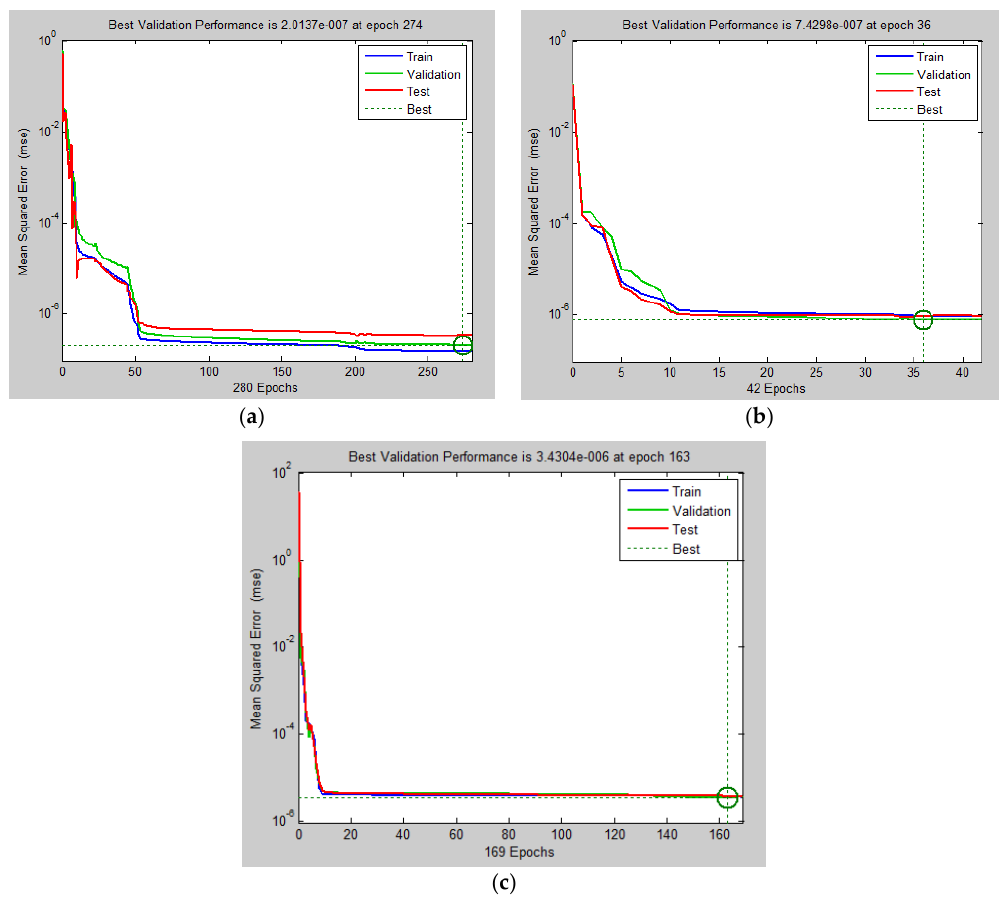
Figure 3. ( a ) Performance plots of the ANN models for E′ ( T ); ( b ) Performance plots of the ANN models for E′′ ( T ); and, ( c ) Performance plots of the ANN models for tan δ( T ).